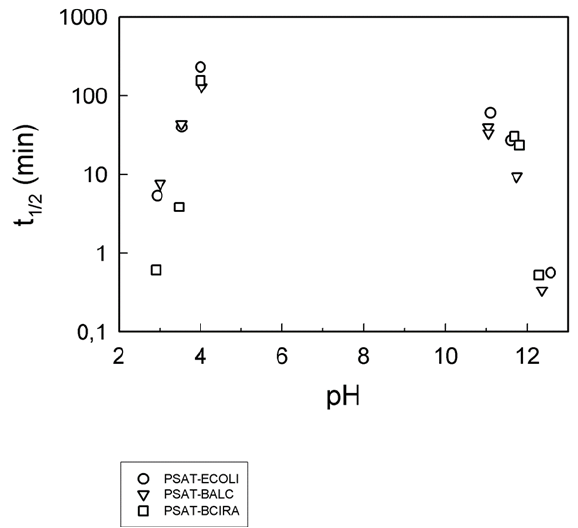
Figure 6: Effect of pH on stability of PSAT-BALC, PSAT-BCIRA and PSAT-ECOLI. 30 µg/ml of PSAT-BALC (∆), PSAT-BCIRA (  ), and PSAT- ECOLI (○) were exposed to 50 mM buffers (citrate, MES, HEPES, borate and carbonate) with 250 mM NaCl (to buffer ionic strength), and 20 µM PLP for 5 – 60 min. At certain time intervals aliquots of enzyme (0.35 µg) were taken and mixed with 200 mM Tris-Cl, pH 8.2, 8 mM Glu, 32 mM ammonium acetate, 250 mM NaCl, and 20 µM PLP. The residual PSAT activity was immediately measured in coupled reaction by adding 10 mM NADH, 24 U GlDH, and 18 mM 3PHP. The slope of inactivation curve, obtained from log percentage of residual activity against preincubation time at different pH values (data not shown), represents the first-order rate constant k (min -1 ) for enzyme inactivation. In this figure obtained data is fitted into plot of t 1/2 versus pH in log scale, t = 0.6931og k . Figure illustrates little 1/2 differences in t among PSATs (note the log scale). Furthermore, 1/2 the inactivation curves were symmetrical at the pH extremes (not